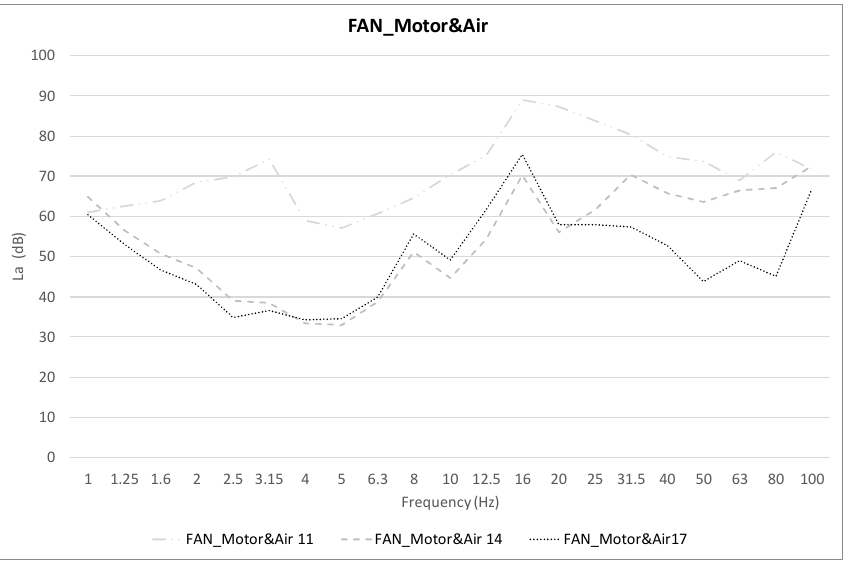
Figure 6. Average La (dB) levels. Positions 11, 14 and 17. FAN_Motor&Air Scenario. In order to be able to study in detail whether there is an influence on vibrations with the room air conditioning, Figure 7 shows the values of the FAN_Motor and FAN_Motor&Air scenarios at the same points shown above (points 11, 14, and 17).